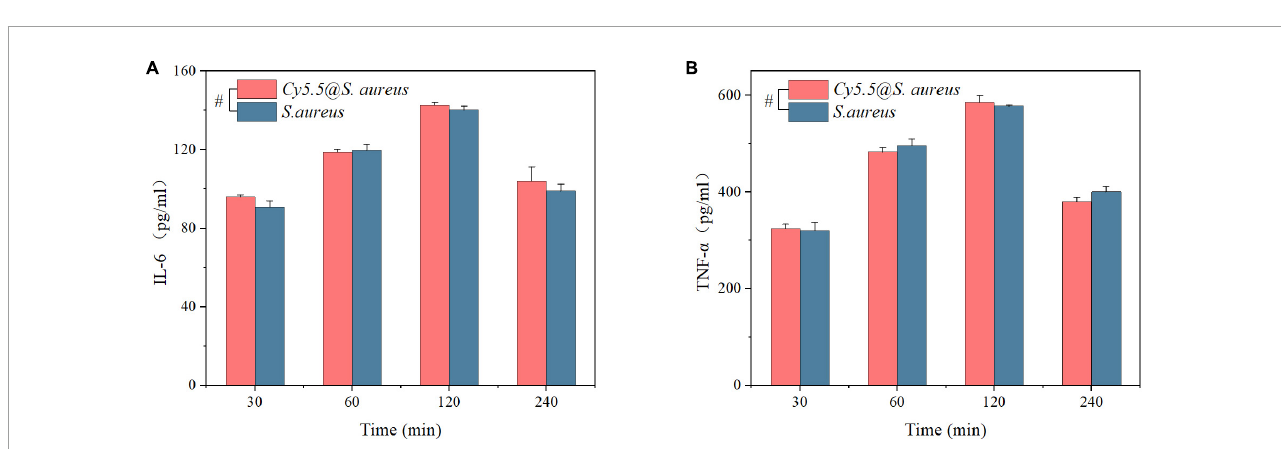
FIGURE7 (A,B) ELISA analysis to detect the secretion of inflammatory factors (IL-6 and TNF- α ) in the supernatant at different time points after infection of RAW264.7 macrophages with Cy5.5@S. aureus and unlabeled Staphylococcus aureus . Data are displayed as mean ± SD. # P > 0.05. N = 3 in each